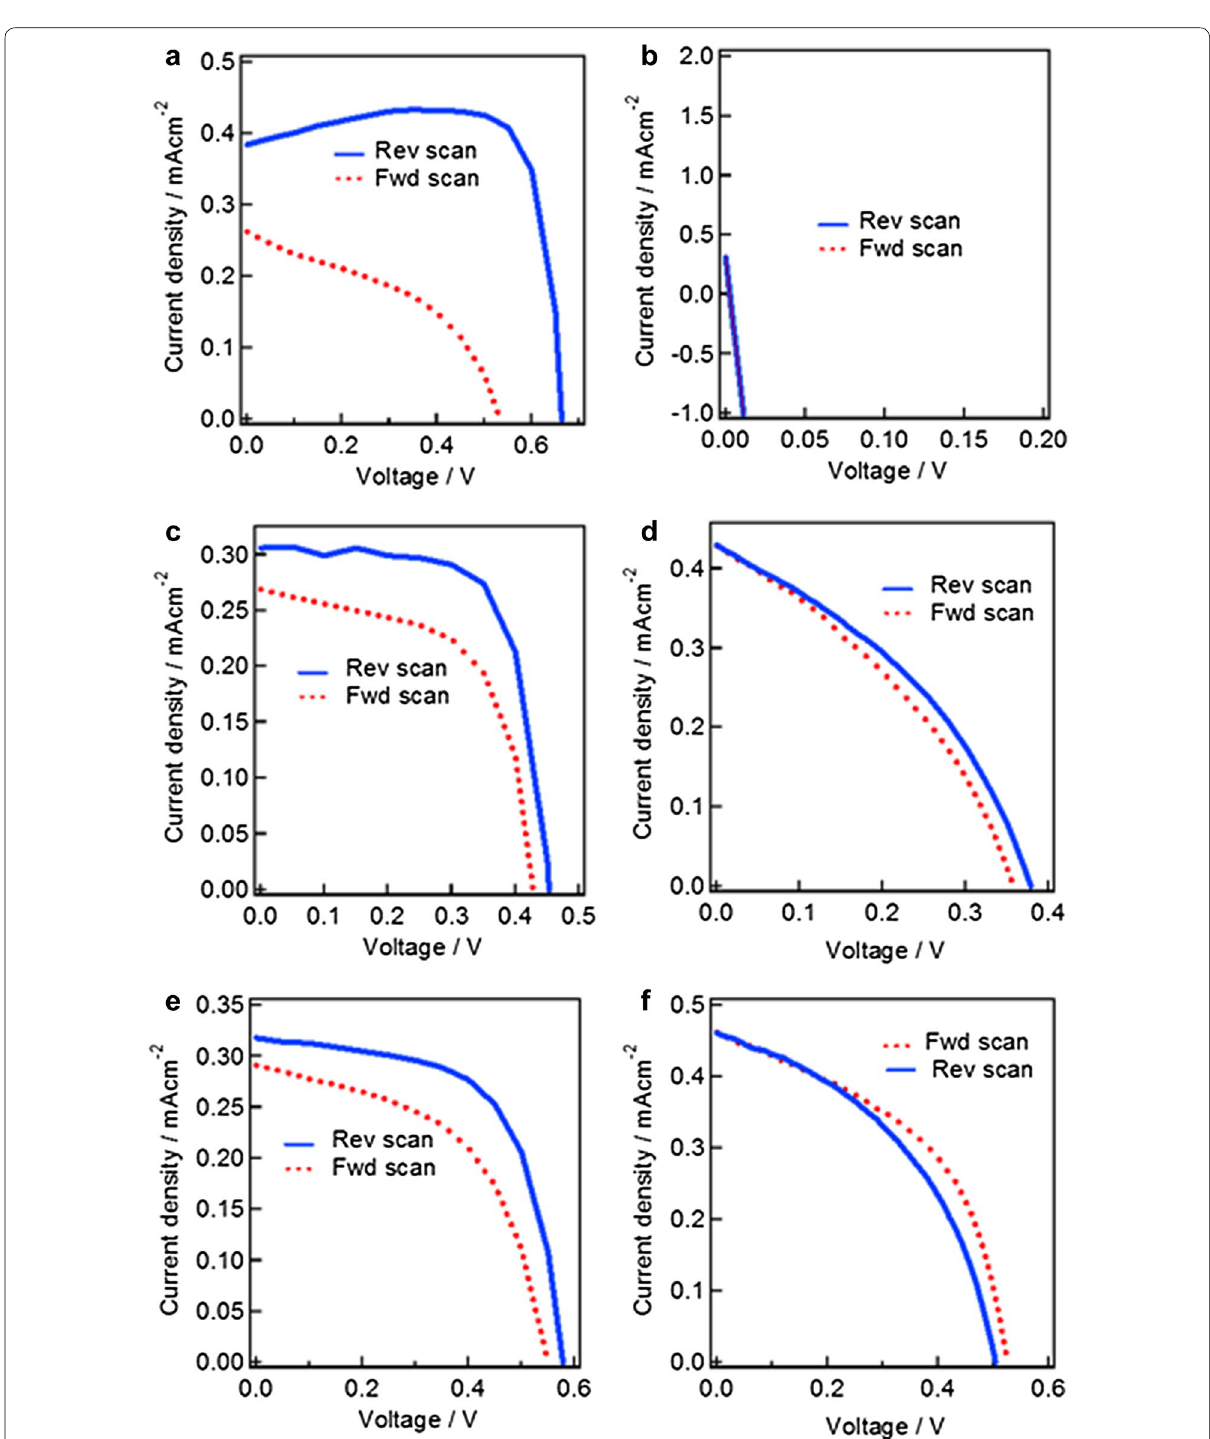
Fig. 5 Photo I–V curves of lead-free A 3 B 2 X 9 -crystal solar cells measured under simulated irradiation (AM 1.5, 100 mW cm − 2 ) as normal mesoscopic and inverted architectures respectively. The photoabsorption layers were